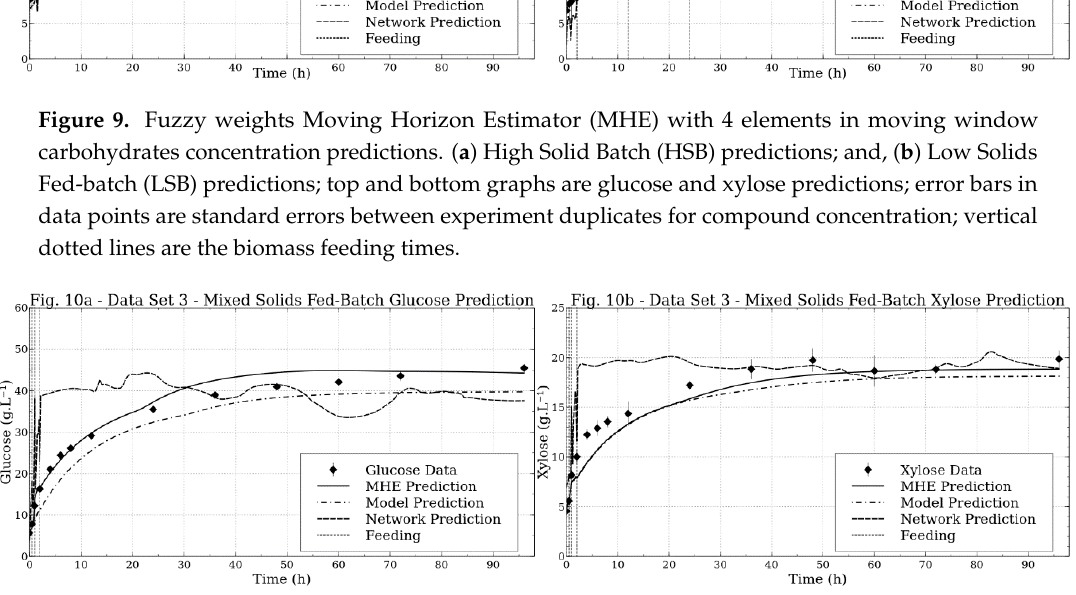
Figure 10. Fuzzy weights Moving Horizon Estimator (MHE) with four elements in moving window: carbohydrate concentration predictions for Mixed Solids Fed-batch (MSF); left and right graphs are glucose and xylose predictions; error bars in data points are standard errors between experiment duplicates for compound concentrations; vertical dotted lines are the biomass feeding times.